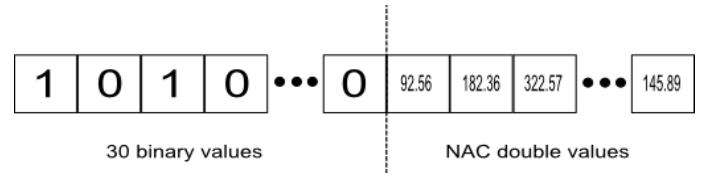
Figure 1. Chromosome encoding for the location and voltage